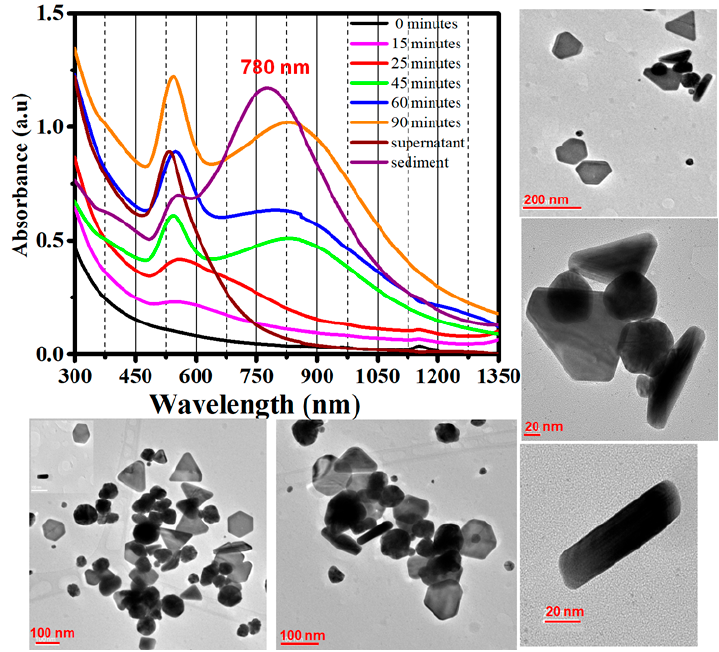
Figure 4. Characterization of NIRAuNM formed within 0.5% wt/v of PNIPAm- co -allylamine microgels by photolysis of 0.033 mmol of Au(Me 2 S)Cl in the aqueous microgel medium by a single-step method. Time-dependent absorption spectra and TEM images are included.